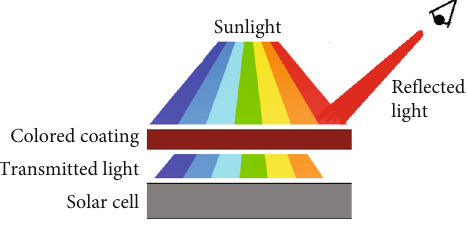
Figure 1: Schematic of a colored solar cell.